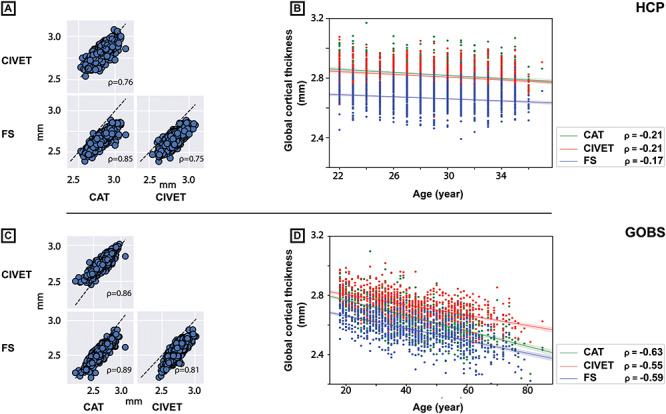
Between-pipeline comparison of global cortical thickness and its interindividual variability. Scatter plots of pair-wise comparison of global cortical estimates and their Spearman’s correlations, within two cohorts. (A, C) Dashed line depicts the identity line(y = x). (B, D) Scatter plots of association between participants’ age and global cortical thickness from each pipeline, for each cohort. Legends depict Spearman’s correlation between age and global thickness of each pipeline.